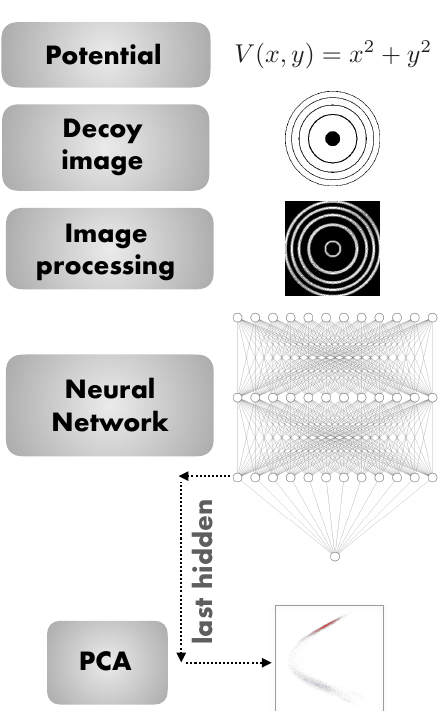
Figure 1: Part I Decoy Task. Schematic view of the main steps of this task: